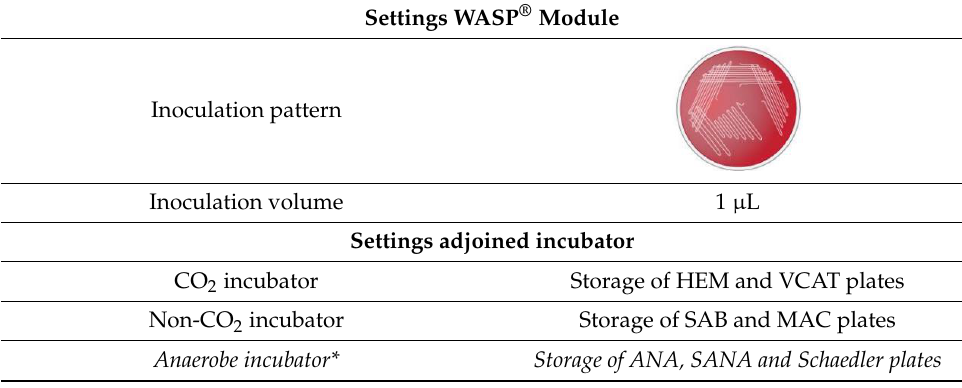
Table 5. Summary of the WASP ® settings and used incubators. For this protocol, we used the five-fold dilution-striking pattern with one µ L volume. The CO 2 incubator and non-CO 2 aerobic incubator from our WASPLab ® system were automatically used after the inoculation. * Due the fact that WASPLab ® do not offer (yet) an anaerobic incubator, these plates had to be placed manually in our anaerobic incubator after inoculating with the WASP ® .